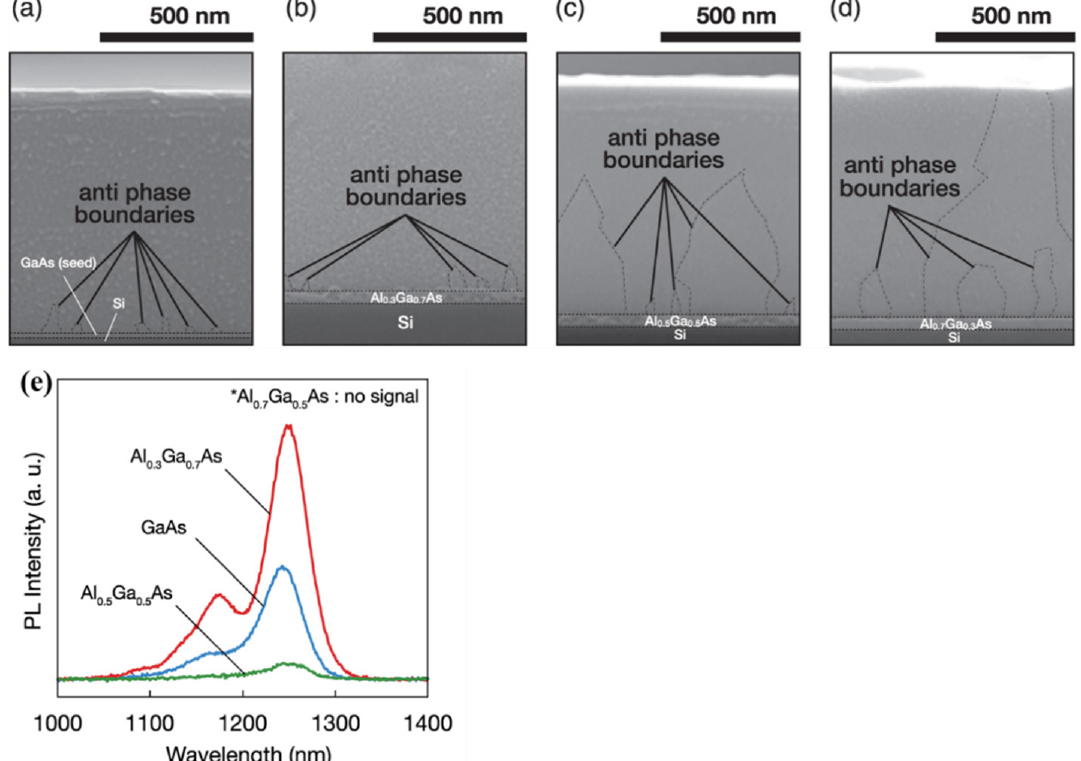
Figure 7. Cross-sectional SEM images of GaAs layer with ( a ) GaAs nucleation layer, ( b ) Al 0.3 Ga 0.7 As nucleation layer, ( c ) Al 0.5 Ga 0.5 As nucleation layer, and ( d ) Al 0.7 Ga 0.3 As nucleation layer grown on (001) Si substrates. ( e ) Room temperature photoluminescence (PL) intensity of an InAs quantum-dot (QD) layer grown on Si with different nucleation layer. Reprinted with permission from Reference [127] © 2019 The Japan Society of Applied Physics.